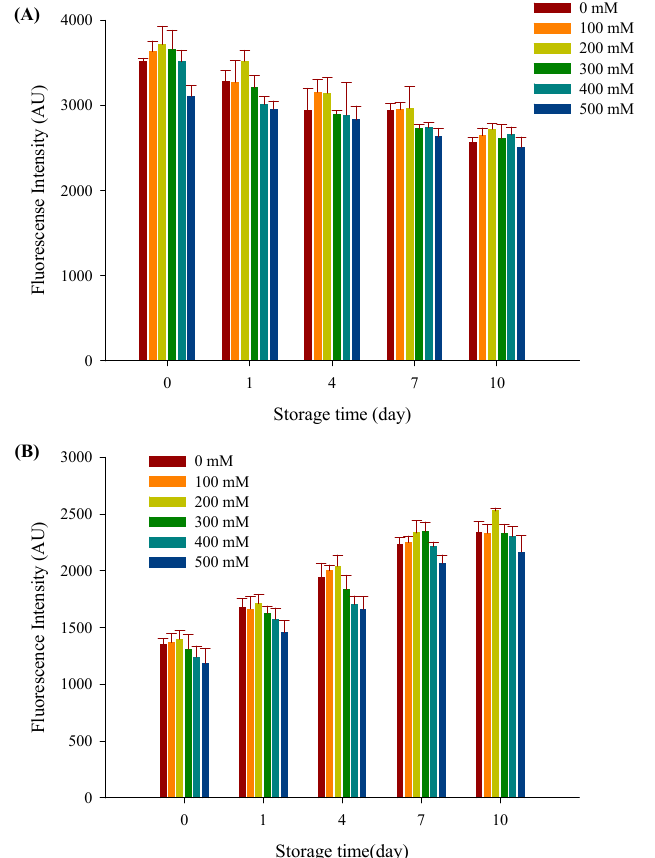
Figure 9. The fluorescence spectra of tryptophan ( A ) and protein oxidation products ( B ) of filled hydrogels treated with different NaCl concentrations at 37 °C during storage.